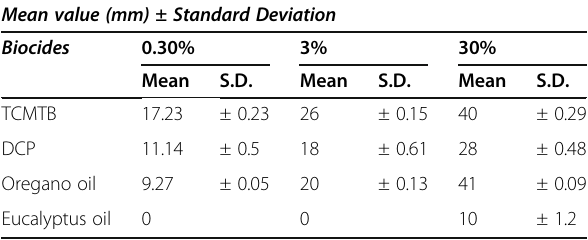
Table 1 Disk diffusion determined zones of inhibition (mm) for A. hydrophila strain after treatment with TCMTB, DCP, oregano oil and eucalyptus oil Mean value (mm) ± Standard